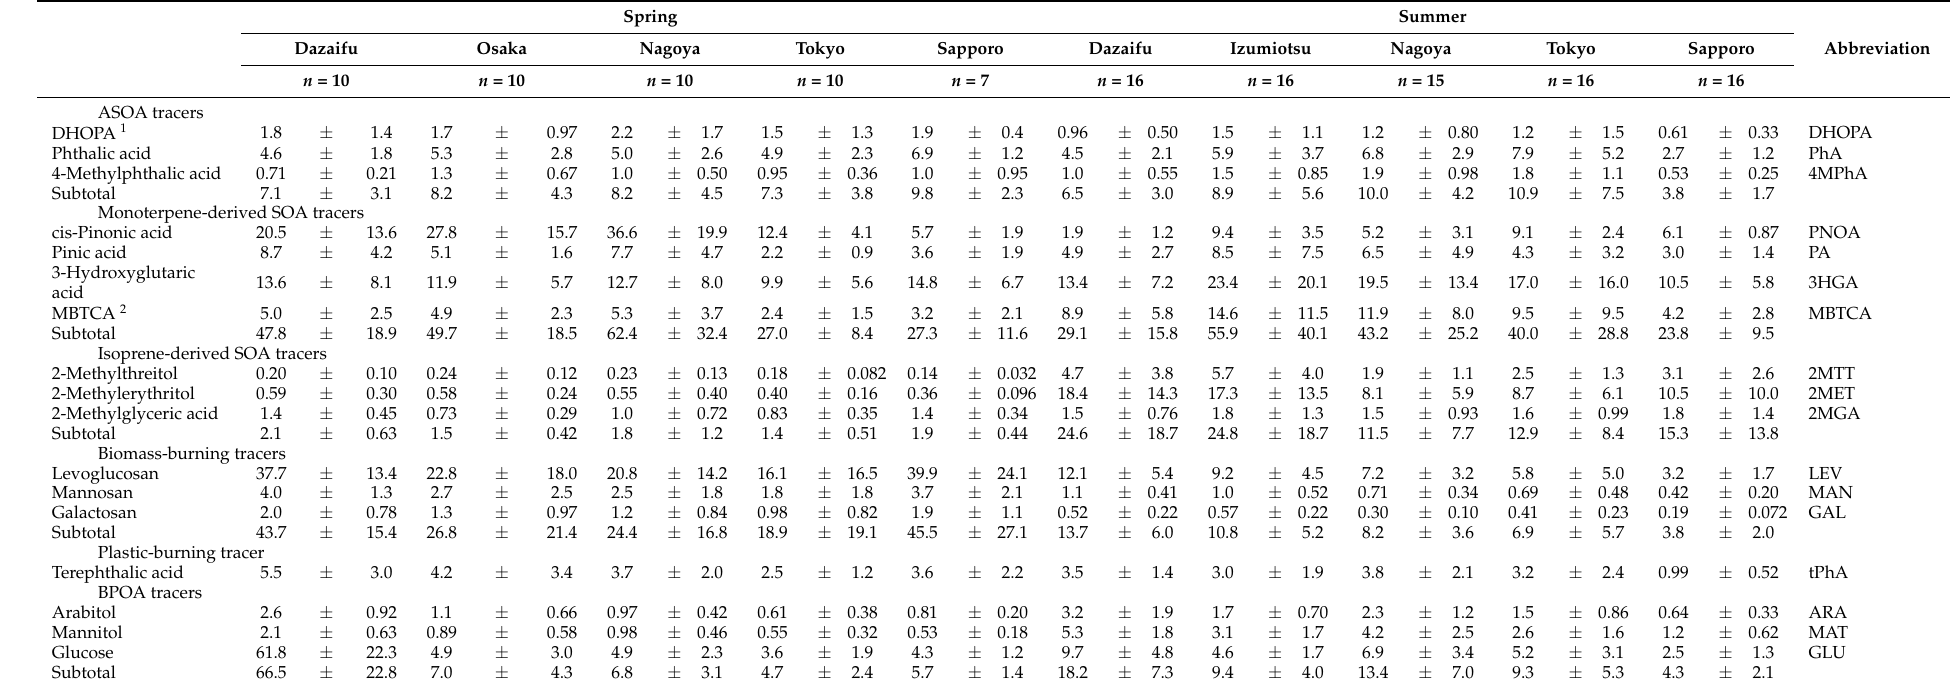
Table 3. Organic tracer concentrations (ng/m 3 ) in PM 2.5 during spring and summer at each